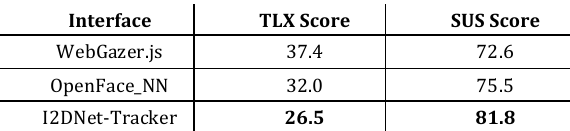
Table 2: Qualitative metrics of our user study Interface TLX Score SUS Score WebGazer.js